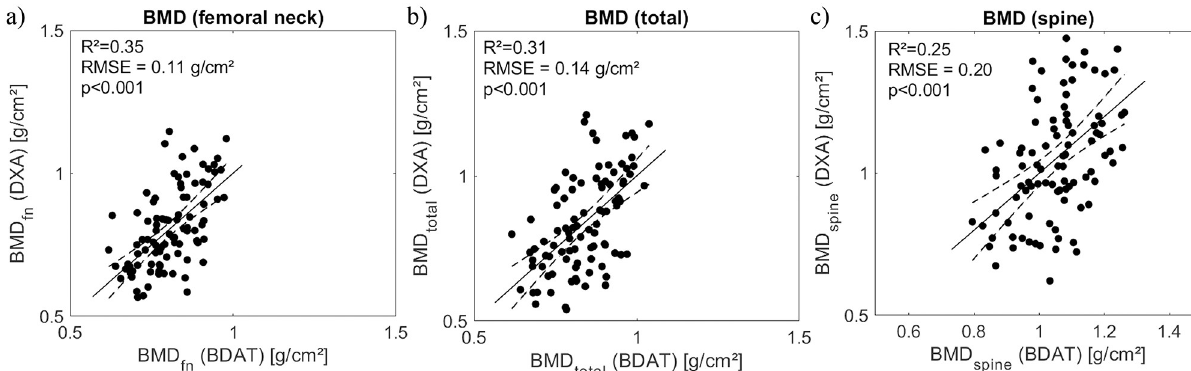
Fig 3. Estimation of aBMD at femur neck (a), total femur (b) and spine (c) from ultrasound Bi-Directional Axial Transmission and anthropometric parameters using PLS regression.